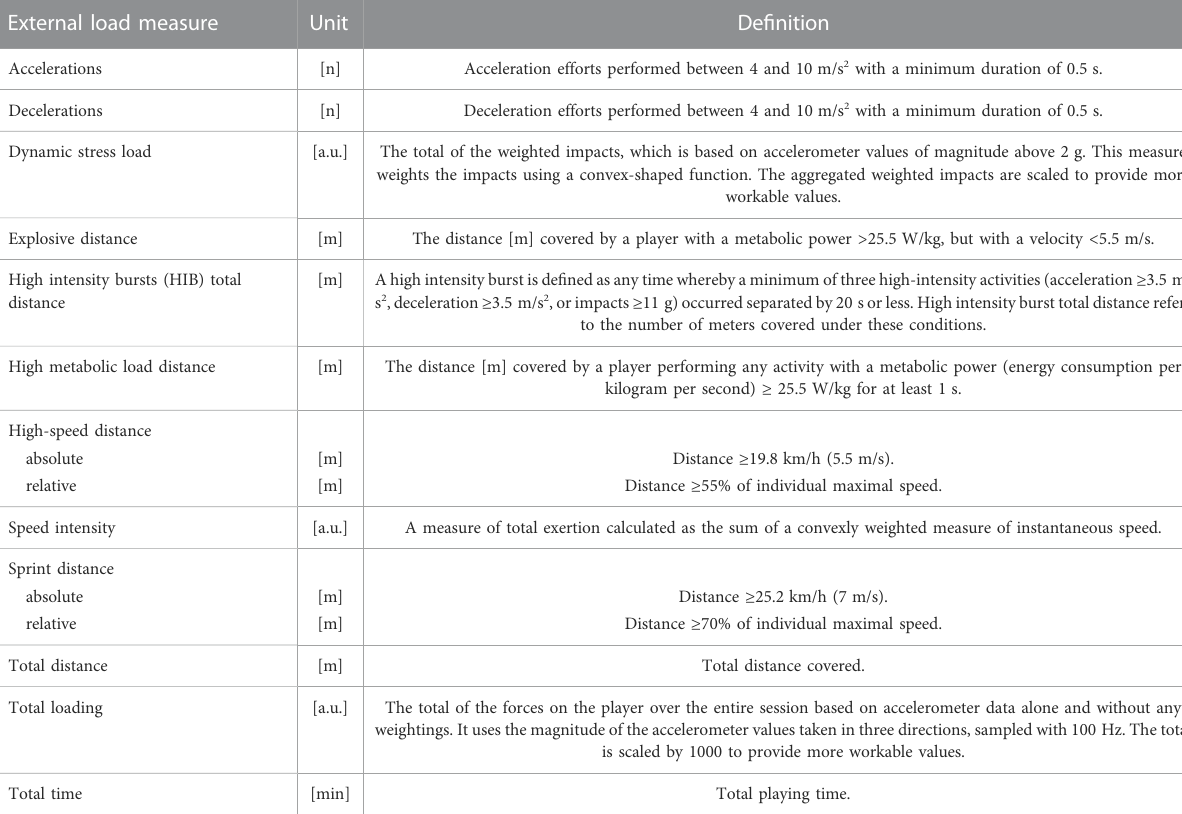
TABLE 2 De fi nitions and units of the external load measures included in the analysis. a.u. = arbitrary